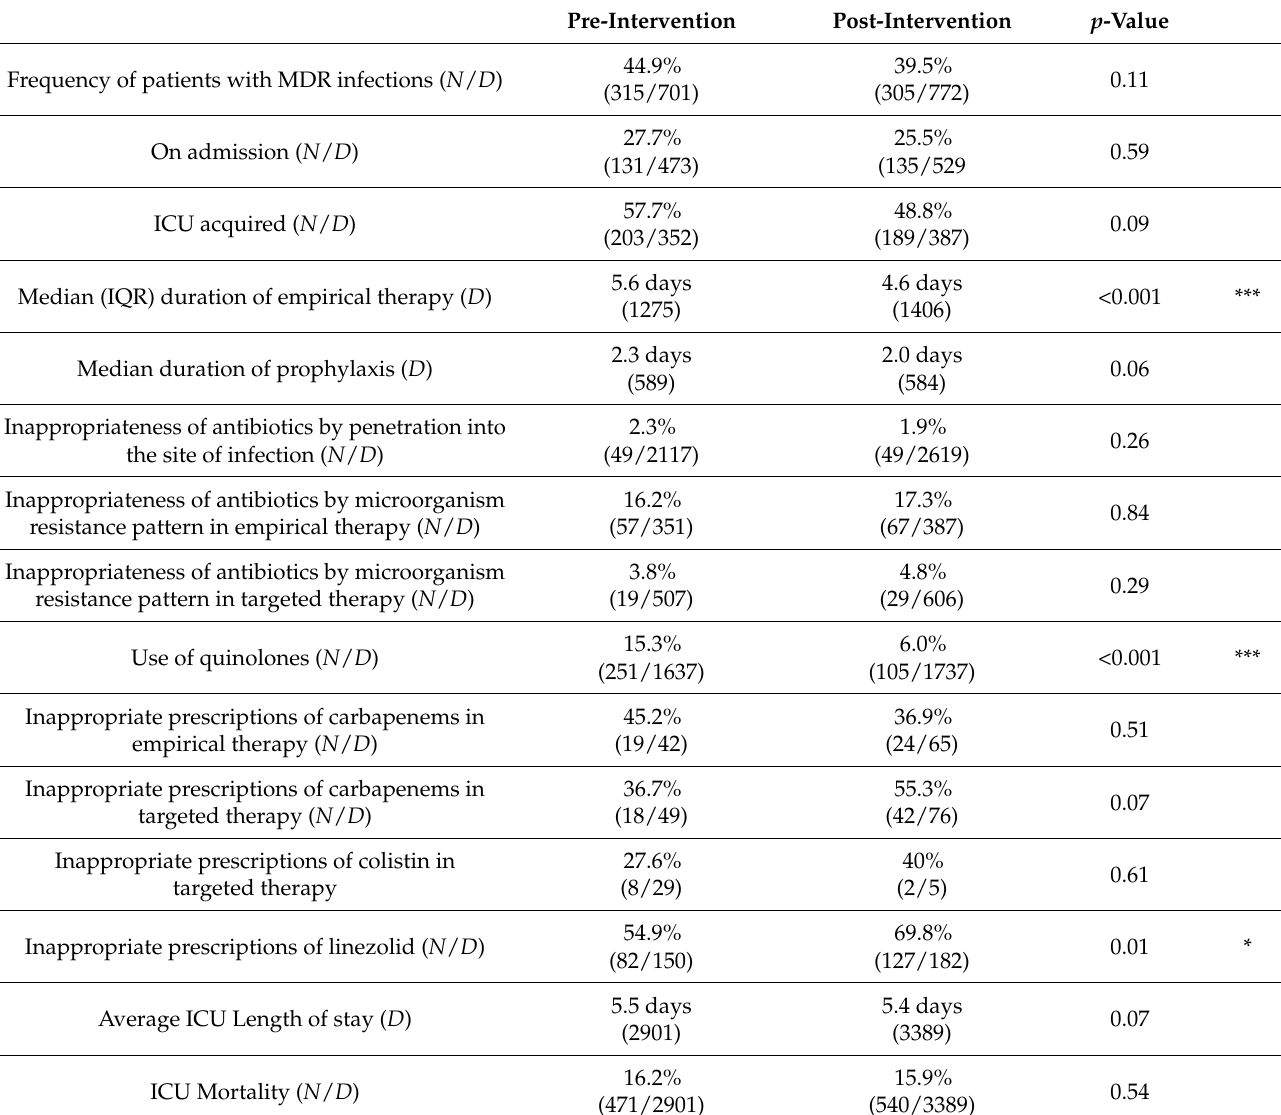
Table 2. Endpoints with % pre-/post- (aggregated) and p -values for all indicators. Significant levels are indicated as * p < 0.05, *** p <